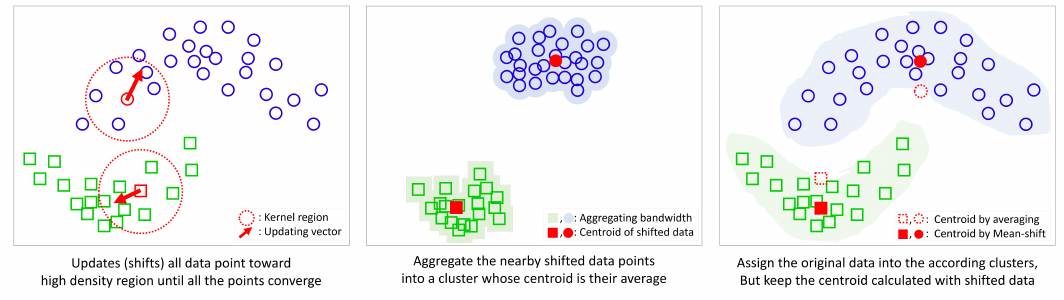
Figure 1. Example for clusters formation and centroid discovery with Mean-Shift